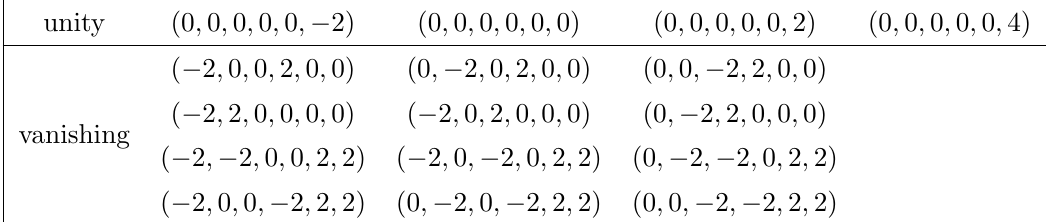
Table 2. The list of all inequivalent and admissible r (cid:12)elds for 6d SO(8) gauge